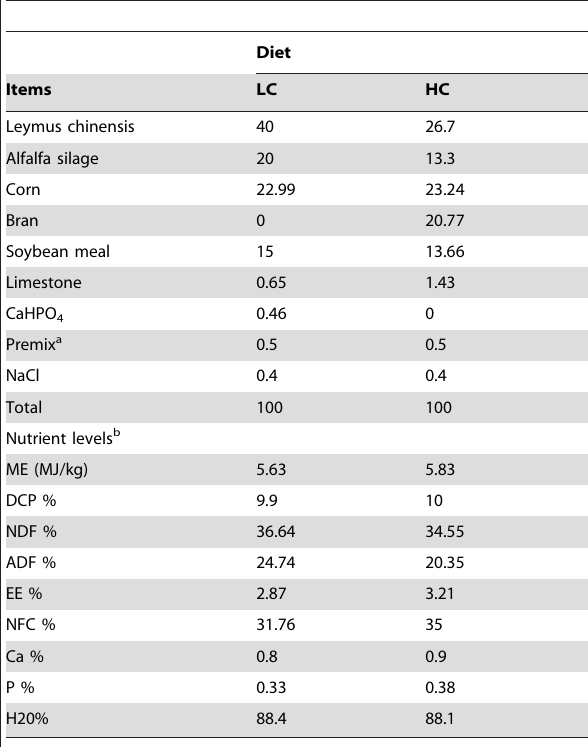
Table 5. Nutrient composition and forge to concentrate ratio (F:C) of the